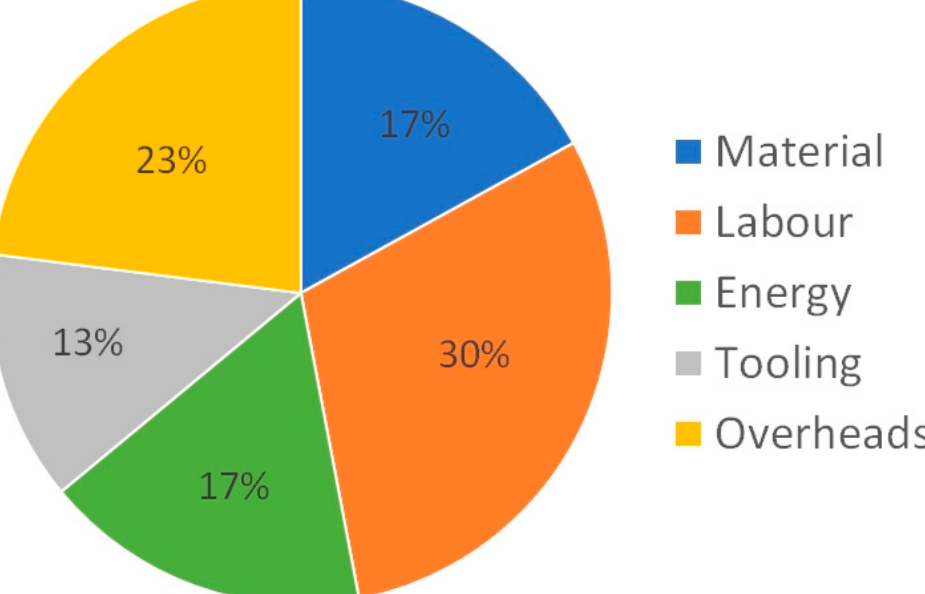
Figure 7. Contribution of the different cost drivers to the total cost.